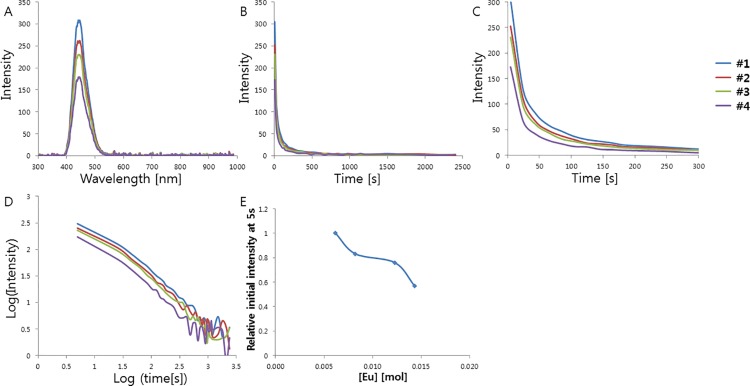
(A) Emission spectrum of CaAl2O4:Eu2+, Nd3+ crystals depending on Eu2+ concentration. (B) Decay curves depending on Eu2+ concentration. (C) Magnified views of the graph in (B). (D) Decay curves in log scale depending on Eu2+ concentration. (E) Relative initial intensity measured at 5s (relative values where the value of control sample #1 is 1.0) depending on Eu2+ concentration.